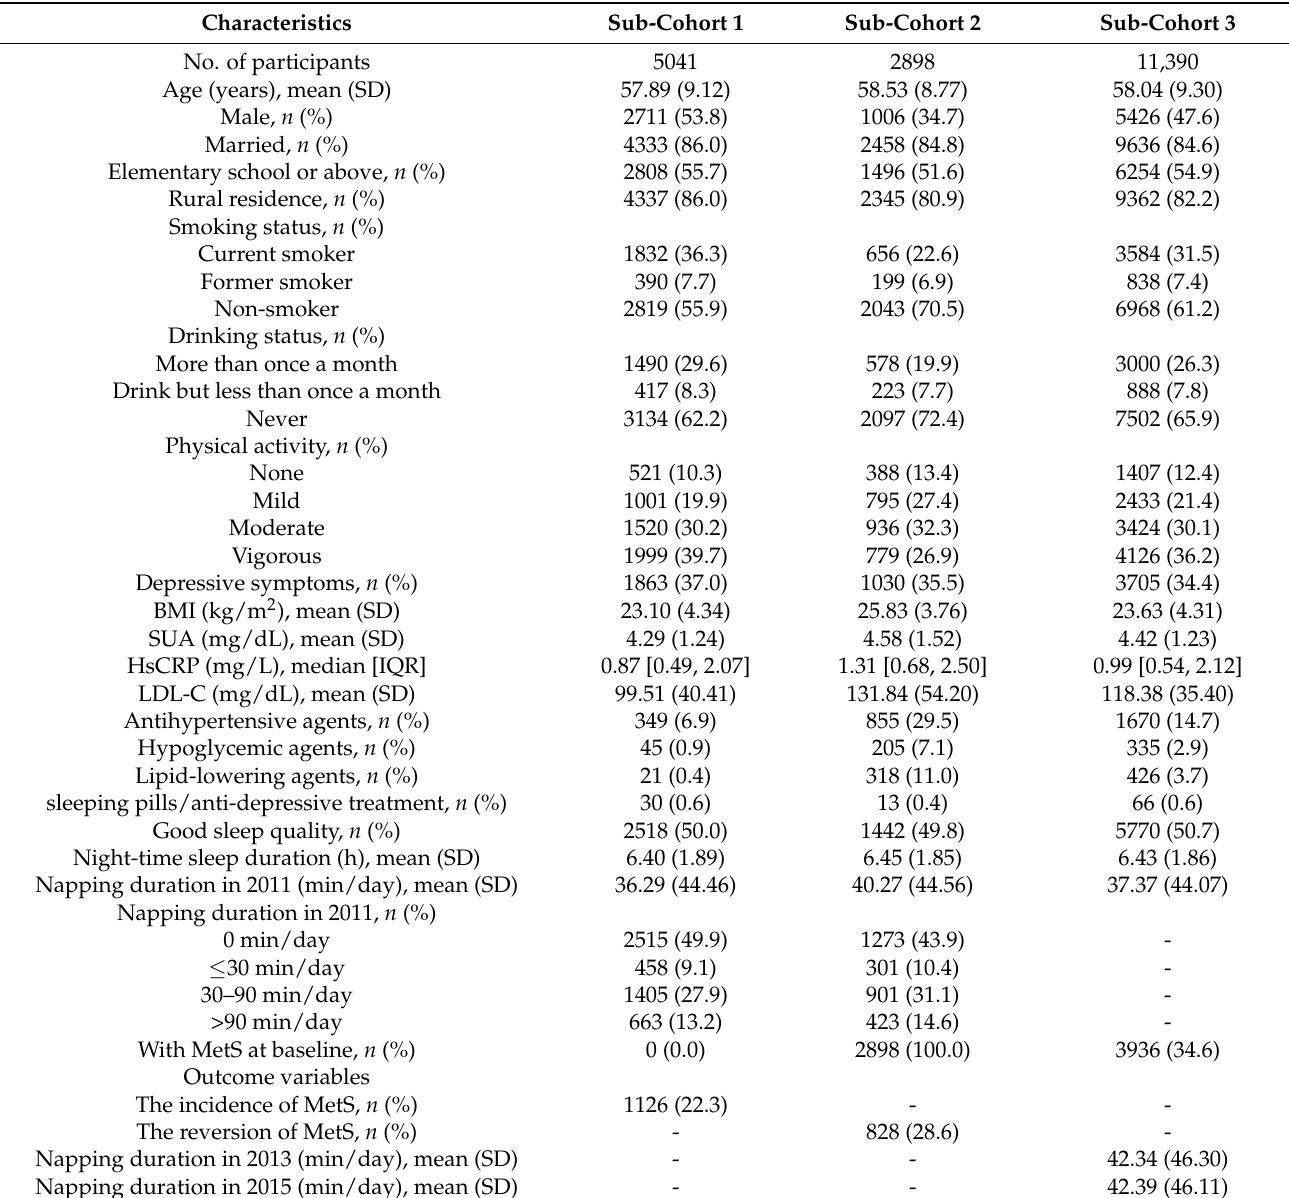
Table 1. Baseline characteristics of the study population in three